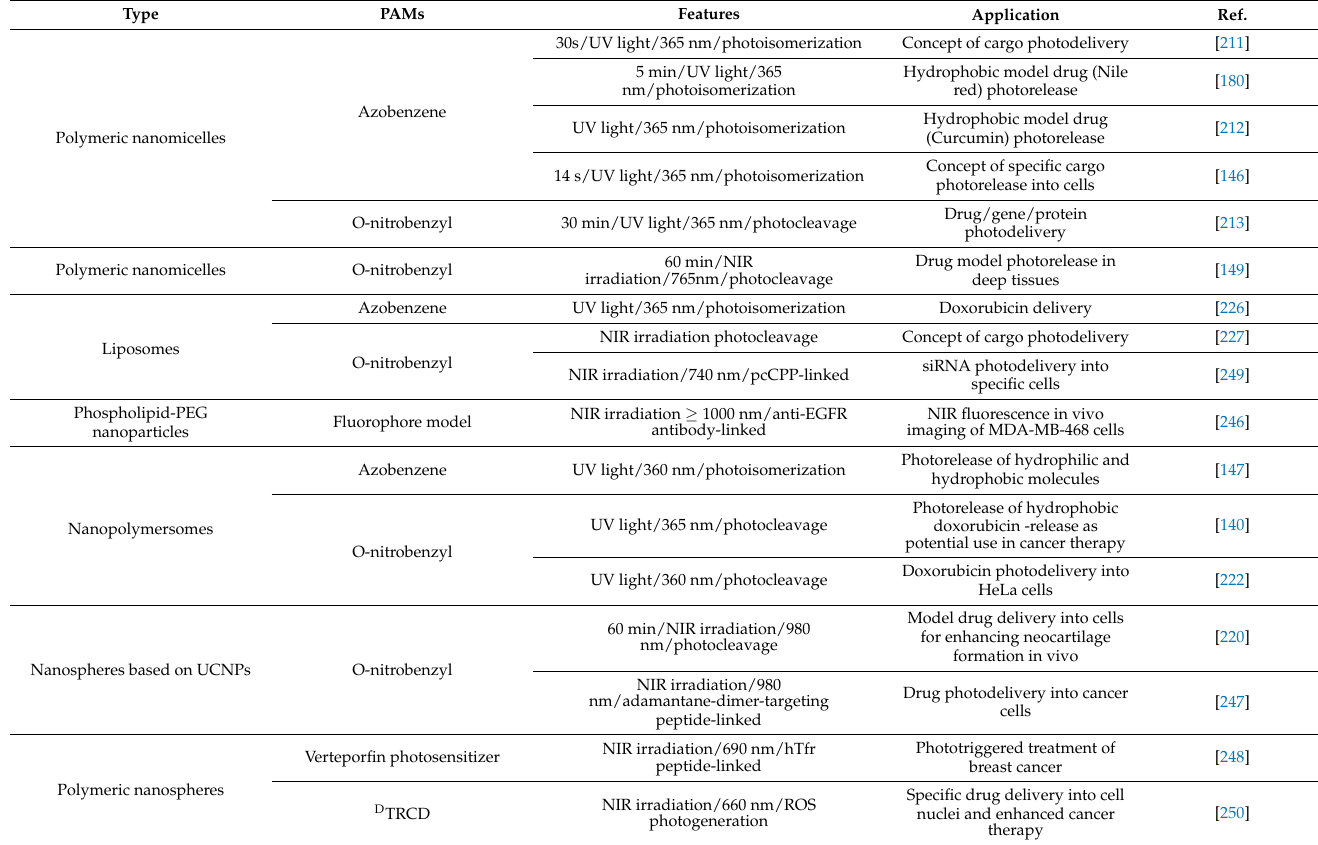
Table 3. Photosensitive micro/nanocarriers for biomedical